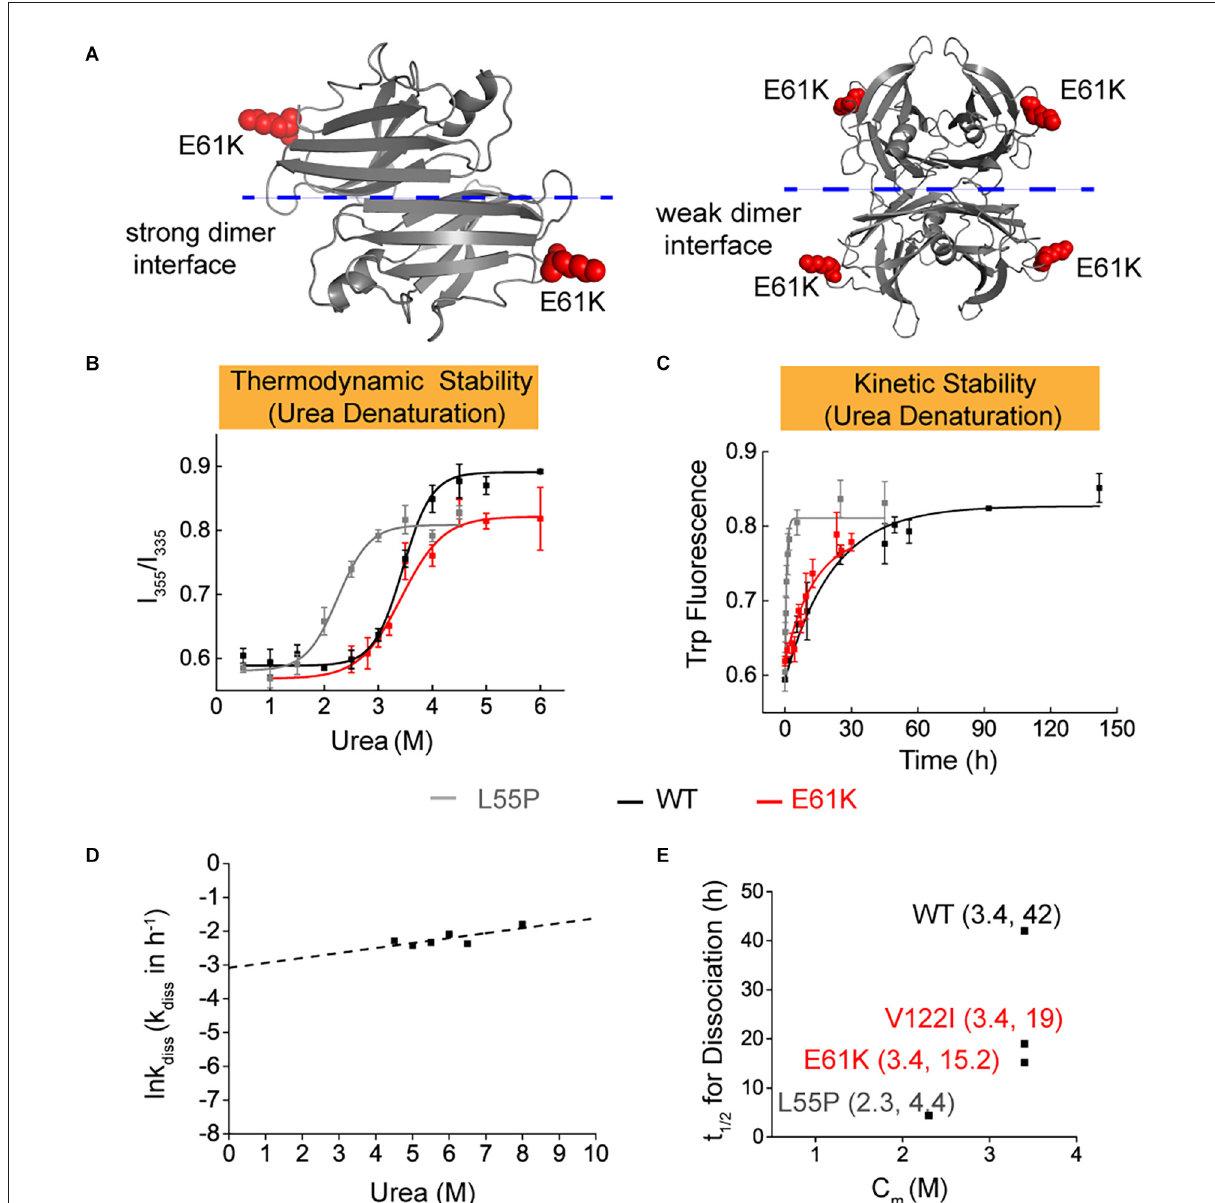
FIGURE2 Thermodynamic and kinetic stability of E61K-TTR mutant protein. (A) X-ray crystallographic structure of E61K-TTR, modified based on previously reported structure (PDB code: 1BMZ). K61 was highlighted on the DE loop in red. (B) Thermodynamic stability of TTR and its mutants was measured by urea denaturation curve using tryptophan intrinsic fluorescence. (C) Kinetic stability of TTR and its mutants was measured by tryptophan fluorescence in 6.5 M urea. L55P, gray curve; WT, black curve; E61K, red curve. (D) The logarithm of the rate of tetramer dissociation, lnkdiss (kdiss in h-1), was plotted as a function of urea concentrations. The lnkdiss vs. urea concentration plot is linear, allowing extrapolation to 0Murea. (E) Summaryofthermodynamic(X-axis;Cmvalues)andkinetic(Y-axis; t 1/2 oftetramerdissociation)stability,indicatingitscompromised kinetic stability in E61K-TTR